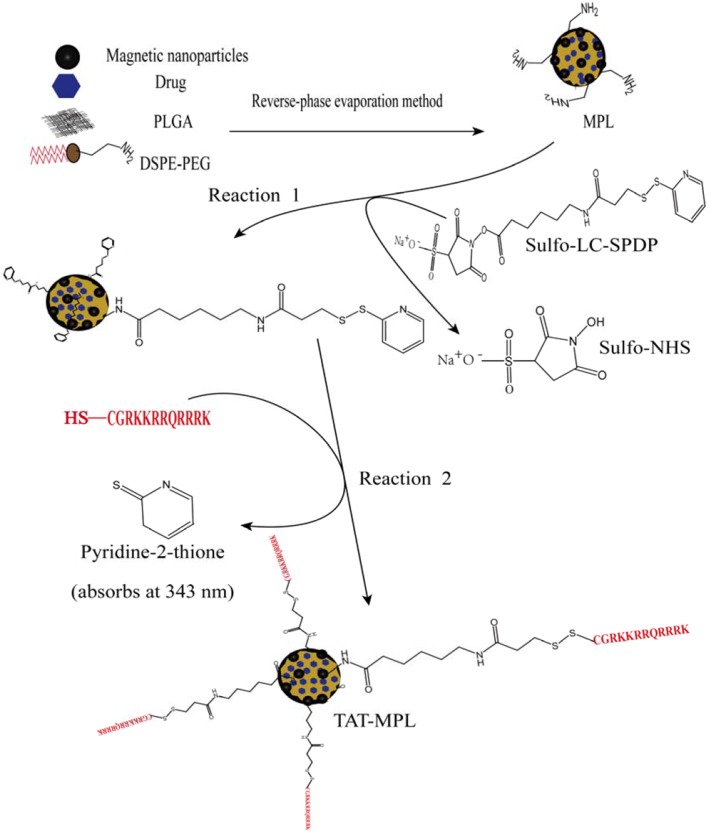
Schematic of the preparation of stealth MPLs and the conjugation of TAT peptide to MPLs.